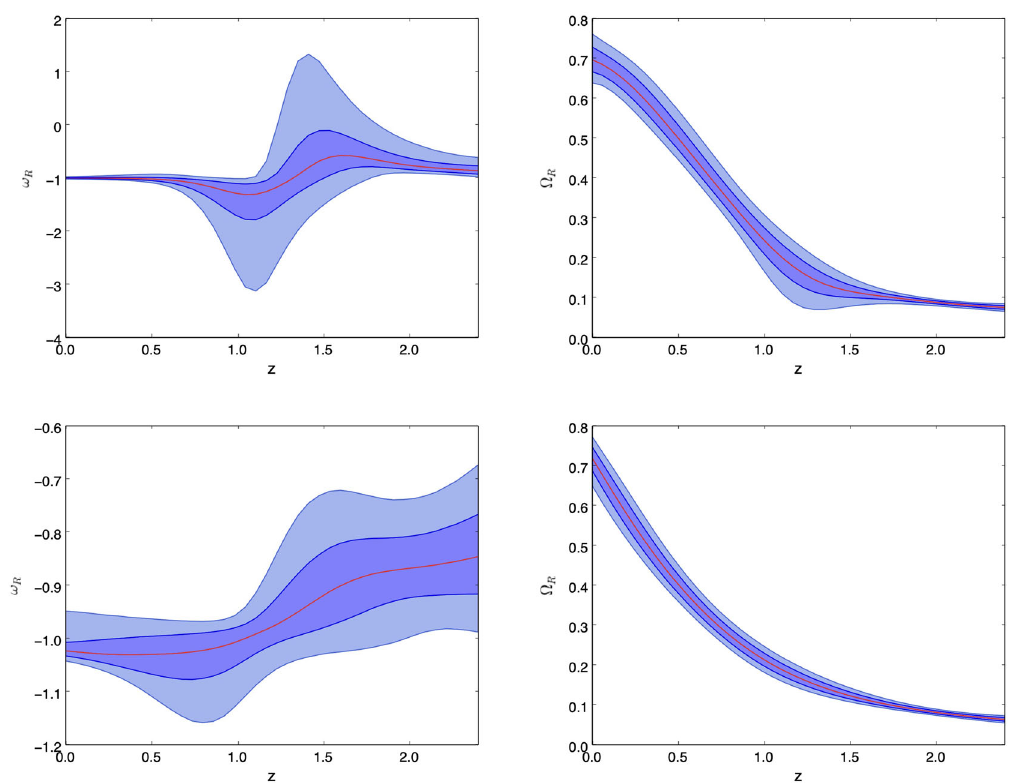
solid line is the mean of the reconstruction and the shaded blue regions are the 68% and 95% C.L. of the reconstruction, respectively. From the reconstruction of (cid:13) R = ρ R the constraints on α , β , γ and C are found 3 H 2 to be α = − 0 . 000017 ± 0 . 000005, β = 1 . 12 ± 0 . 04, C = 2 . 18 ± 0 . 04 , when H 0 = 73 . 52 ± 1 . 62 km s − 1 Mpc − 1 . On the other hand, for